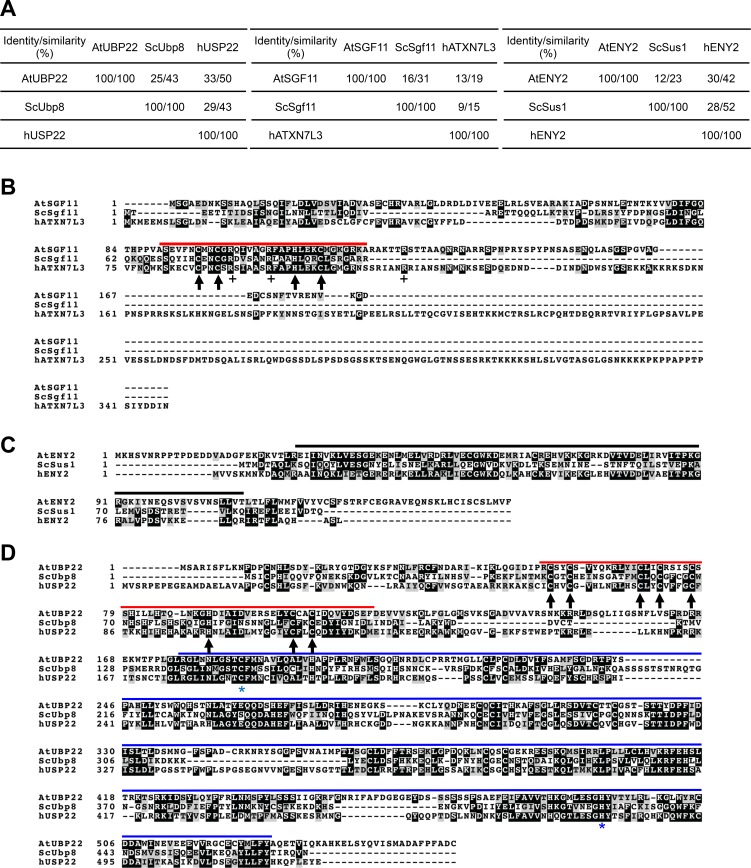
Amino-acid sequence alignments of Arabidopsis, S.cerevisiae and human SGF11, ENY2/SUS and UBP22/Ubp8/USP22 proteins.(A) Identity and similarity matrix between each protein obtained after EMBOSS Needle using Needleman-Wunsch alignment algorithm (Li et al., 2015). (B–D) Clustal Omega protein sequence alignments colored with Boxshade. Identical and similar residues are given a black or grey background, respectively. Red lines, ZN-finger domains. Blue line, UBP domain. Black lines, ENY2-like domain. Black arrows, conserved ZN-finger residues. Blue stars, conserved catalytic UBP residues. AtUBP22 is At5g10790; AtSGF11 is AT5G58575; AtENY2 is AT3G27100.